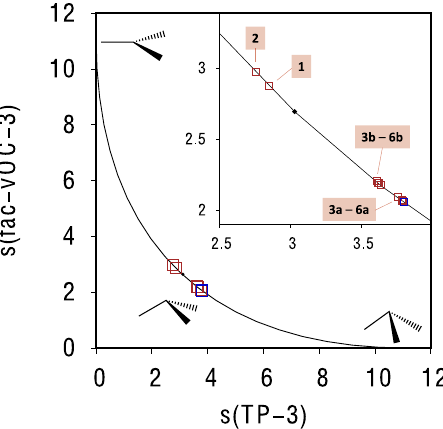
Fig. 9 Shape analysis of the interacting methyl group. Minimal Interconversion pathway between a fac-vacant octahedron (fac-vOC-3) and a planar trigonal (TP-3) shape with the corresponding continuous shape measure (s) values (red squares) for the interacting methyl group of Al(CH 3 ) 3 in all model systems ( 1 , 2 , 3a – 6a , 3b – 6b) . The blue square, which represents the methyl group of a non-interacting Al(CH 3 ) 3 molecule, is shown as reference. The small black dot refers to the position in the curve of a vacant